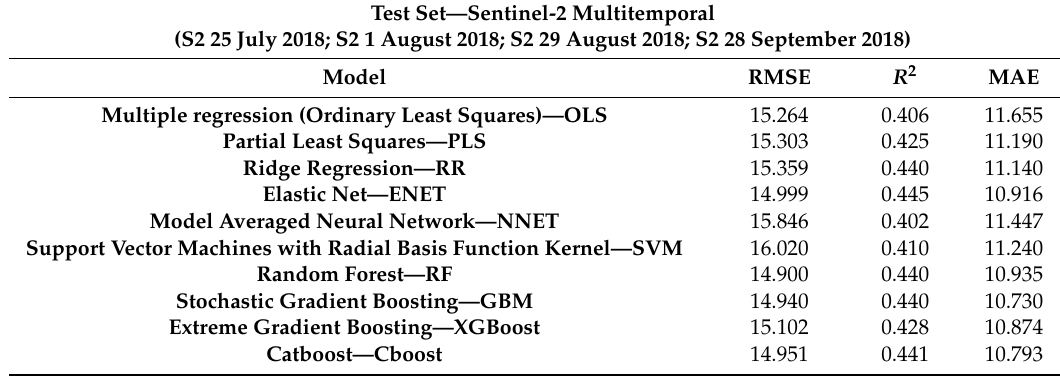
Table 6. Model validation on the testing set: multitemporal S-2